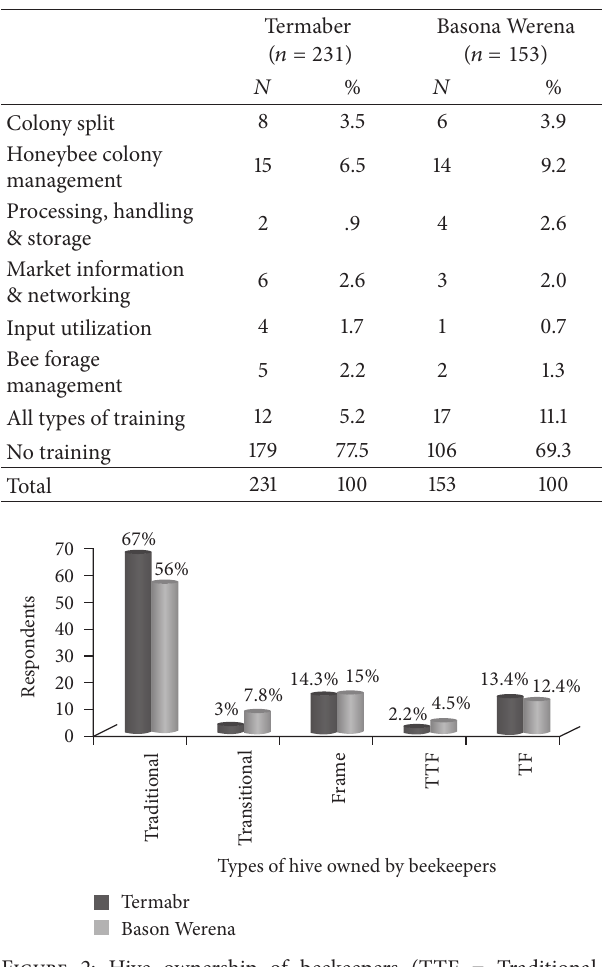
Table 3: Knowledge and necessary skills training offered to the respondent.